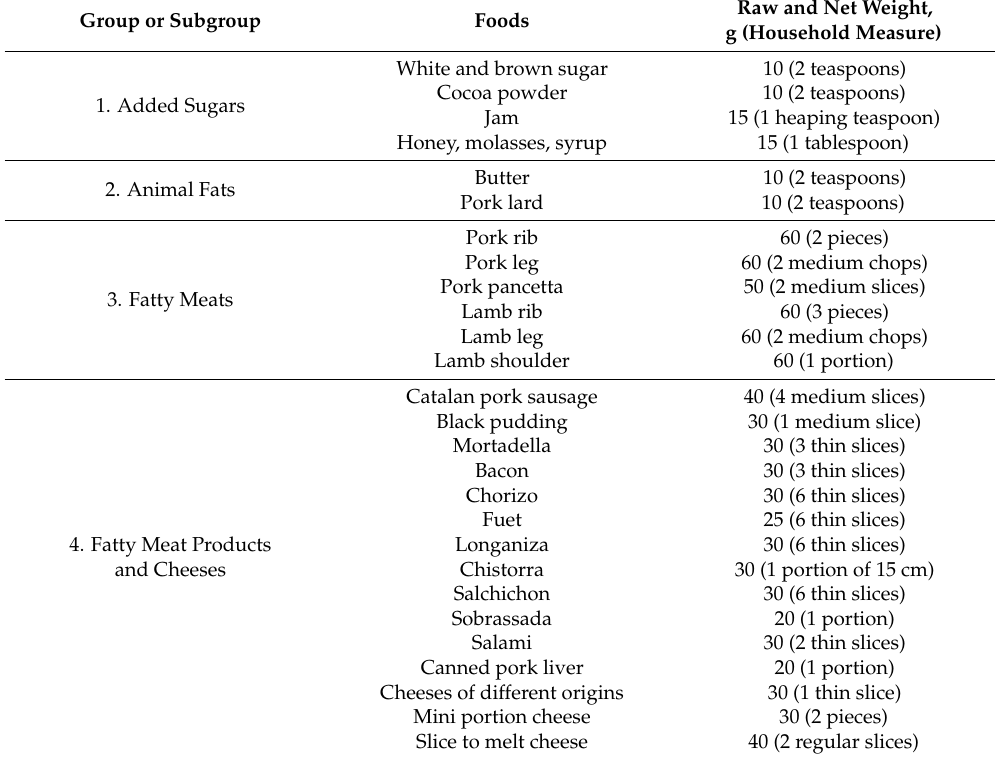
Table 2. Food groups and serving sizes proposed to the occasional